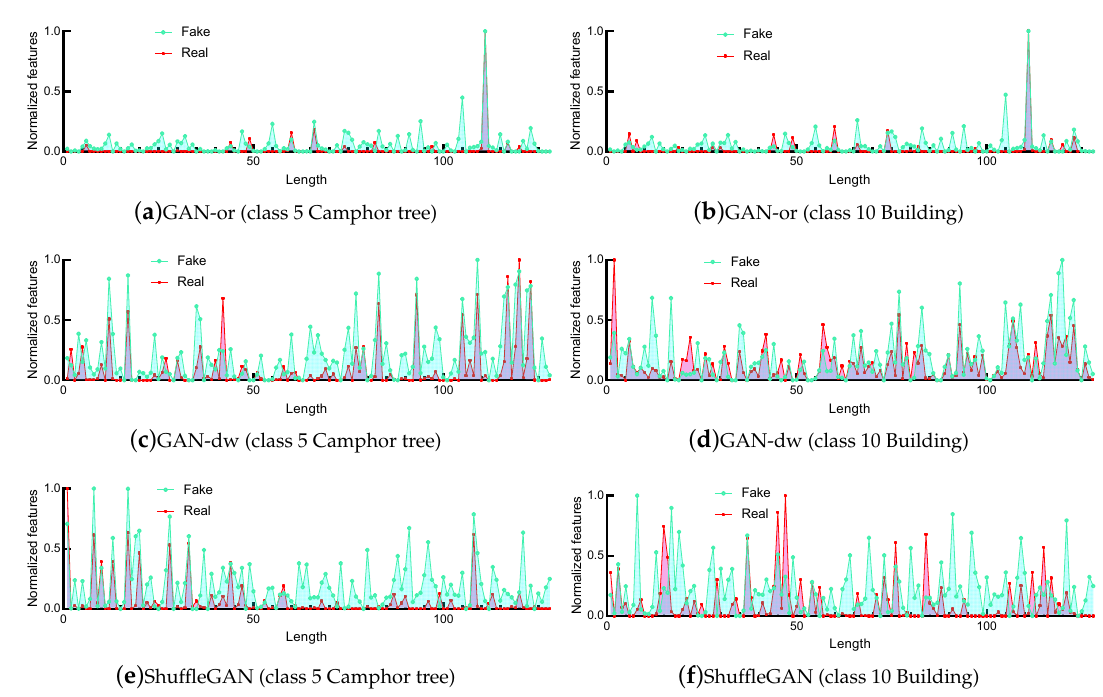
Figure 11. Normalized features of class 5 (Camphor tree) and class 10 (Building) in the real data and generated fake data obtained by various methods. ( a , b ) GAN-or, ( c , d ) GAN-dw and ( e , f ) ShuffleGAN.